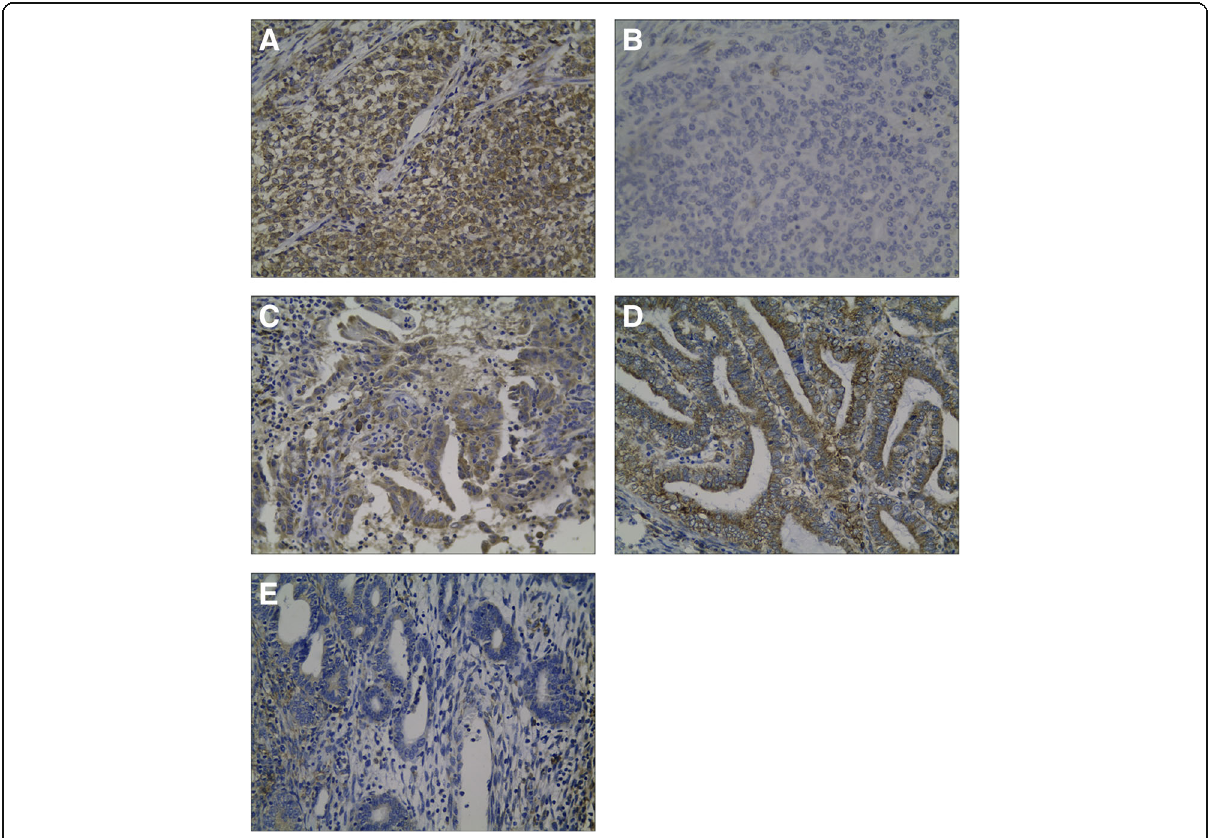
Fig. 2 Representative immunohistochemical staining of RRBP1 in endometrial endometrioid adenocarcinoma specimens (EC): a , Low expression of RRBP1 in a poorly differentiated EC; b , High expression of RRBP1 in a poorly differentiated EC; c , High expression of RRBP1 in a moderatedly differentiated EC; d , High expression of RRBP1 in a well differentiated EC; e , Low expression of RRBP1 in a well differentiated